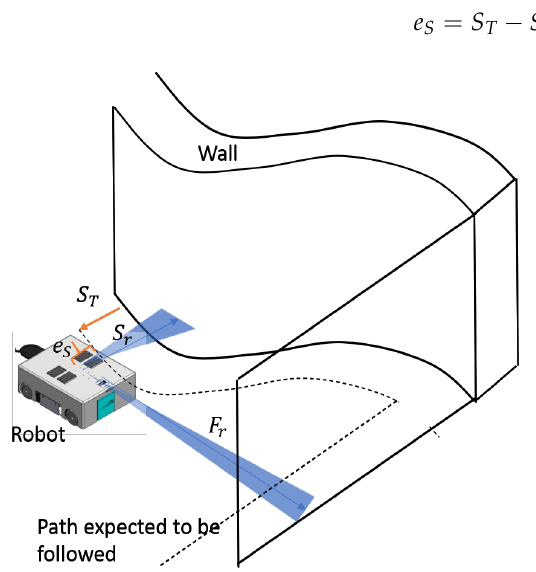
Figure 6. Overview of